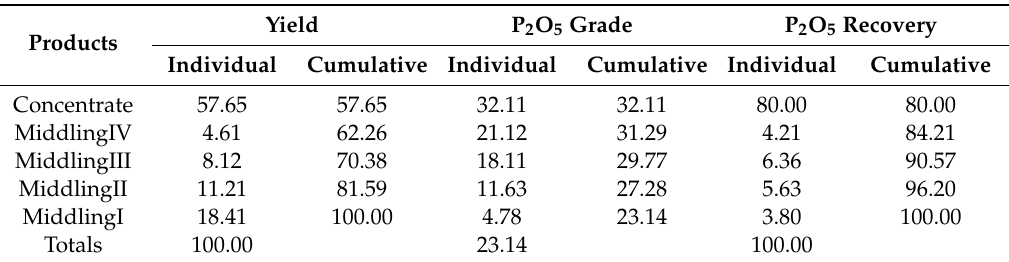
Table 5. Results of the whole flotation test flowsheet of recovering phosphorus (%).